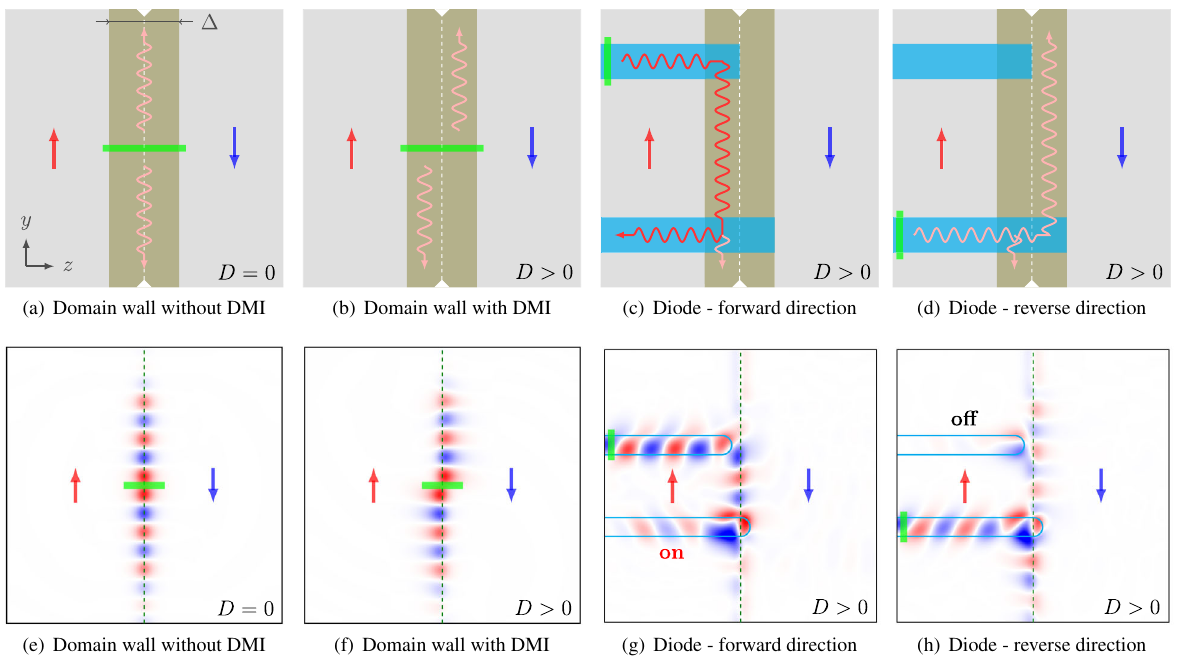
FIG. 2. The design of the diode and the simulations. Top row: The design of the spin-wave diode. (a) Domain-wall wire without DMI. The bound spin-wave state propagates in both directions identically, where the domain-wall region is shaded with darker brown color and is pinned at the kink position. (b) Domain-wall wire with DMI. The bound states propagating upward or downward are spatially shifted to the right or left side of the wall. (c) Spin-wave diode — forward direction. The spin wave transmits from the upper to the lower terminal. (d) Spin-wave diode — reverse direction. The spin wave is blocked from the lower to the upper terminal. The wavy lines denote the route of the spin-wave propagation. Bottom row: Numerical micromagnetic simulations of the spin-wave diode (color map of m z ). (e) Without DMI, the bound spin-wave state travels symmetrically. (f) With DMI, the bound spin-wave states become chiral. (g) Spin-wave diode — the forward direction. (h) Spin-wave diode — the reverse direction. In all panels, the little green bar indicates the spin-wave injection location where an oscillating magnetic field is